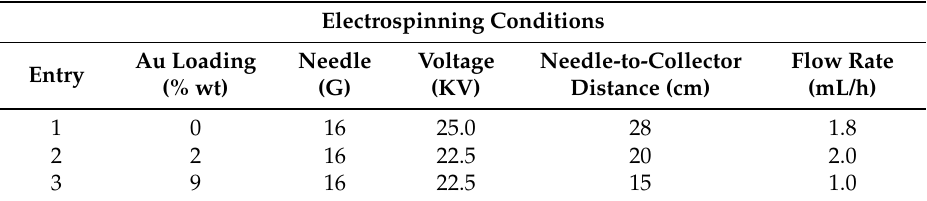
Figure 3. Schematic presentation of the fabrication of polymer-Au NP electrospun fibers starting from highly stable PVP/Au colloidal nanohybrid solutions. Photographs show the nanohybrid PVP/Au solution precursor and the corresponding electrospun PVP/Au nanocomposite membrane. Table 1. Optimum experimental parameters employed for the fabrication of the PVP (pristine) and the PVP/Au nanocomposite electrospun fibrous membranes.